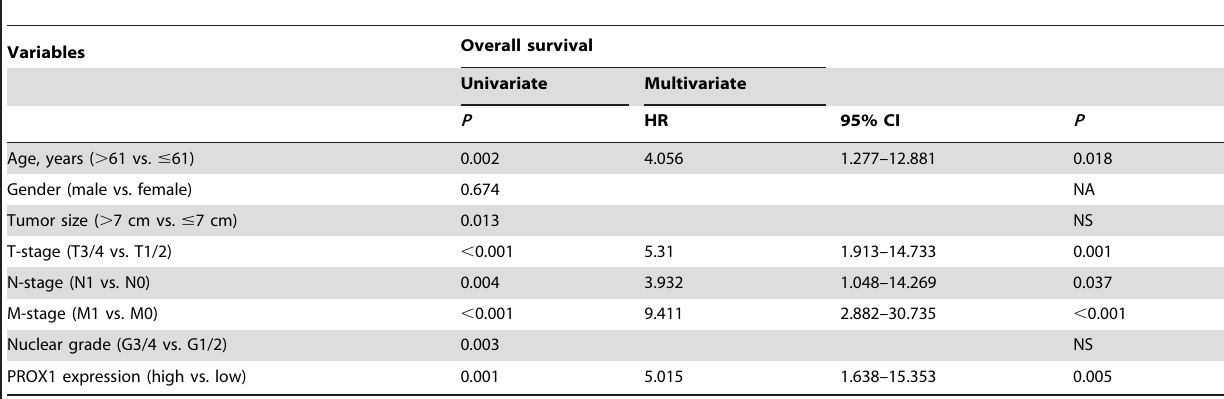
Table 2. Univariate and multivariate analyses of prognostic factors associated with overall survival in RCC.